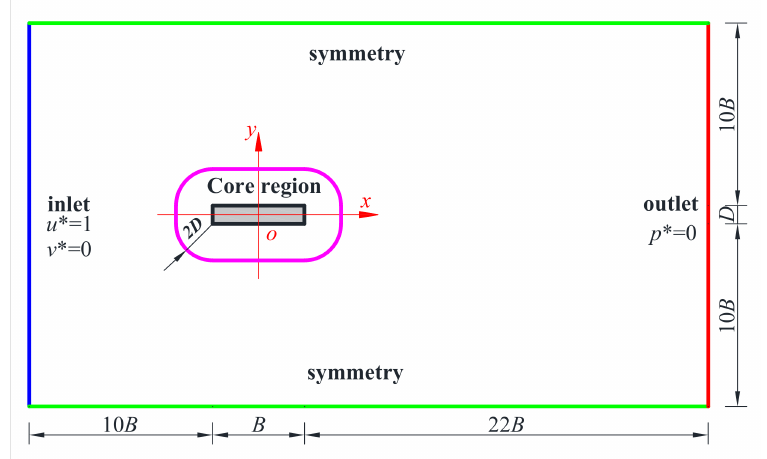
Figure 1. Geometric schematics of the computational domain.